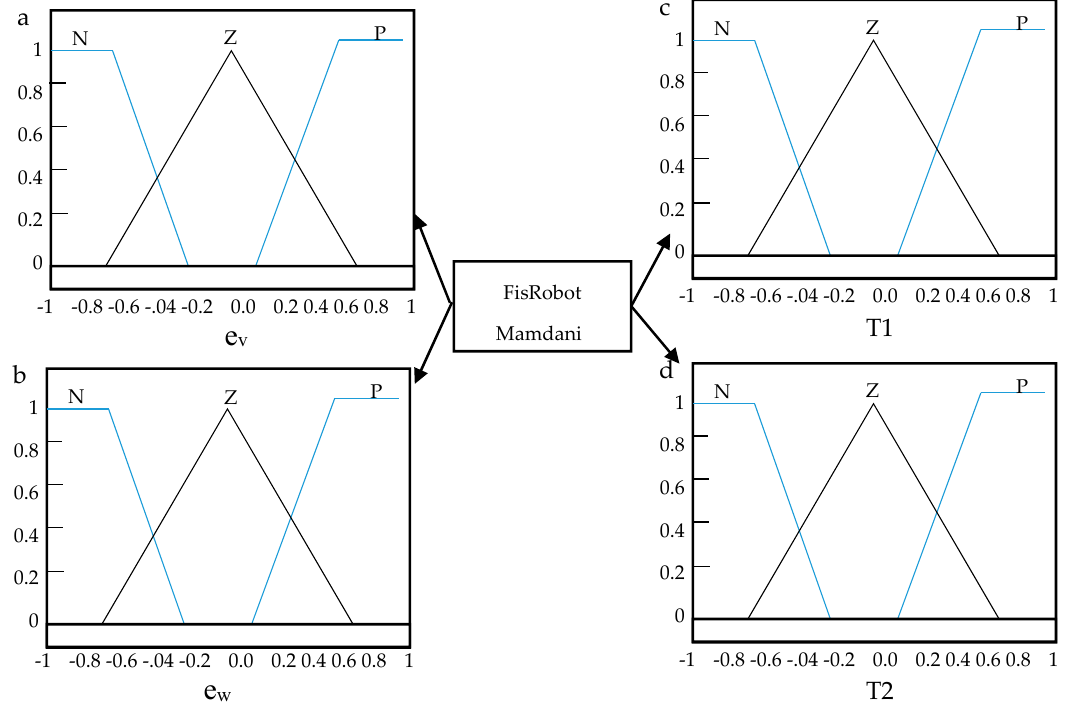
Figure 11. ( a ) Lineal velocity error (e v ); ( b ) angular velocity error (e w ); ( c ) left torque (T1); ( d ) right torque (T2).